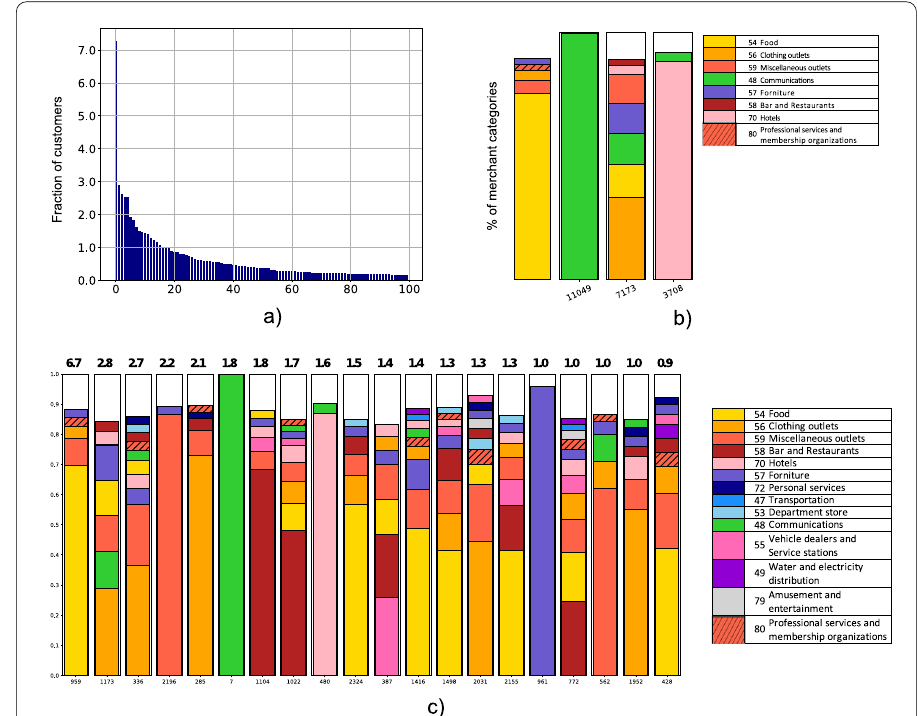
Fig. 4 In a the distribution of the size of the consumption profiles—fraction of customers belonging to a consumption profile over the customer population. In the figure we report the top 100 consumption profiles ordered by their size. In b a selection of representative consumption profiles, visualized as stacked barplots. In c the 20 most frequent representative consumption profiles extracted from the similarity graph on the entire dataset. The profiles are ordered by the fraction of adoption displayed on top of each stacked bar. In b , c we display only categories associated with a component of the representative consumption profile greater than 0.01, for the sake of